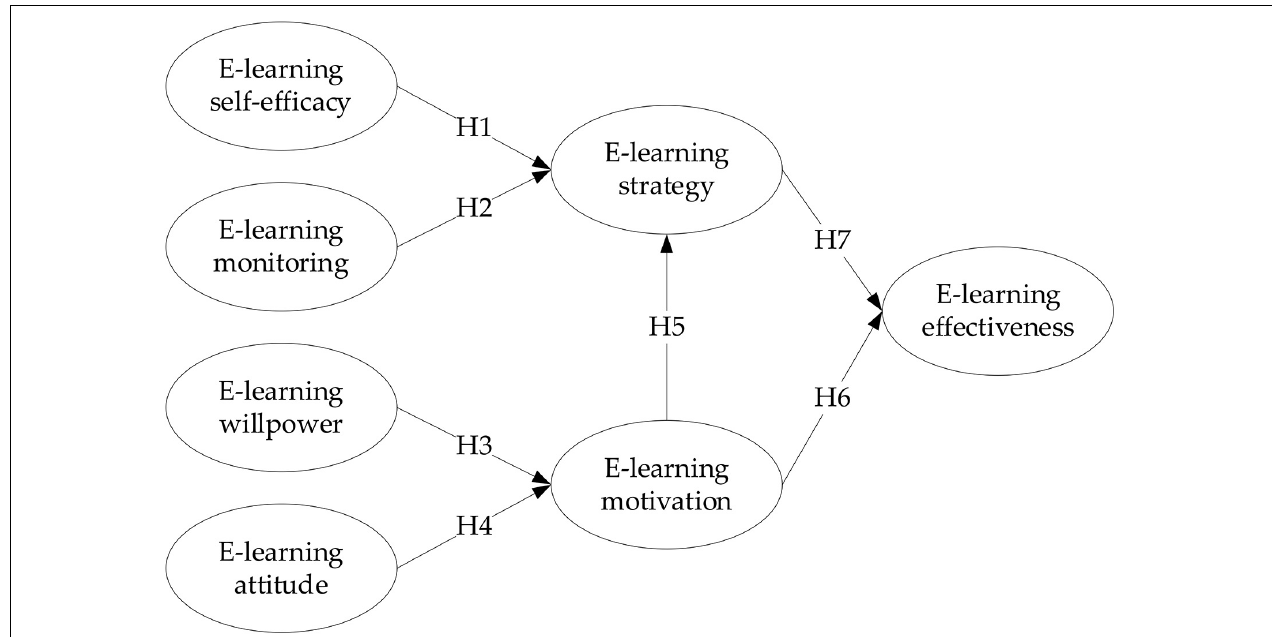
FIGURE 1 | Research